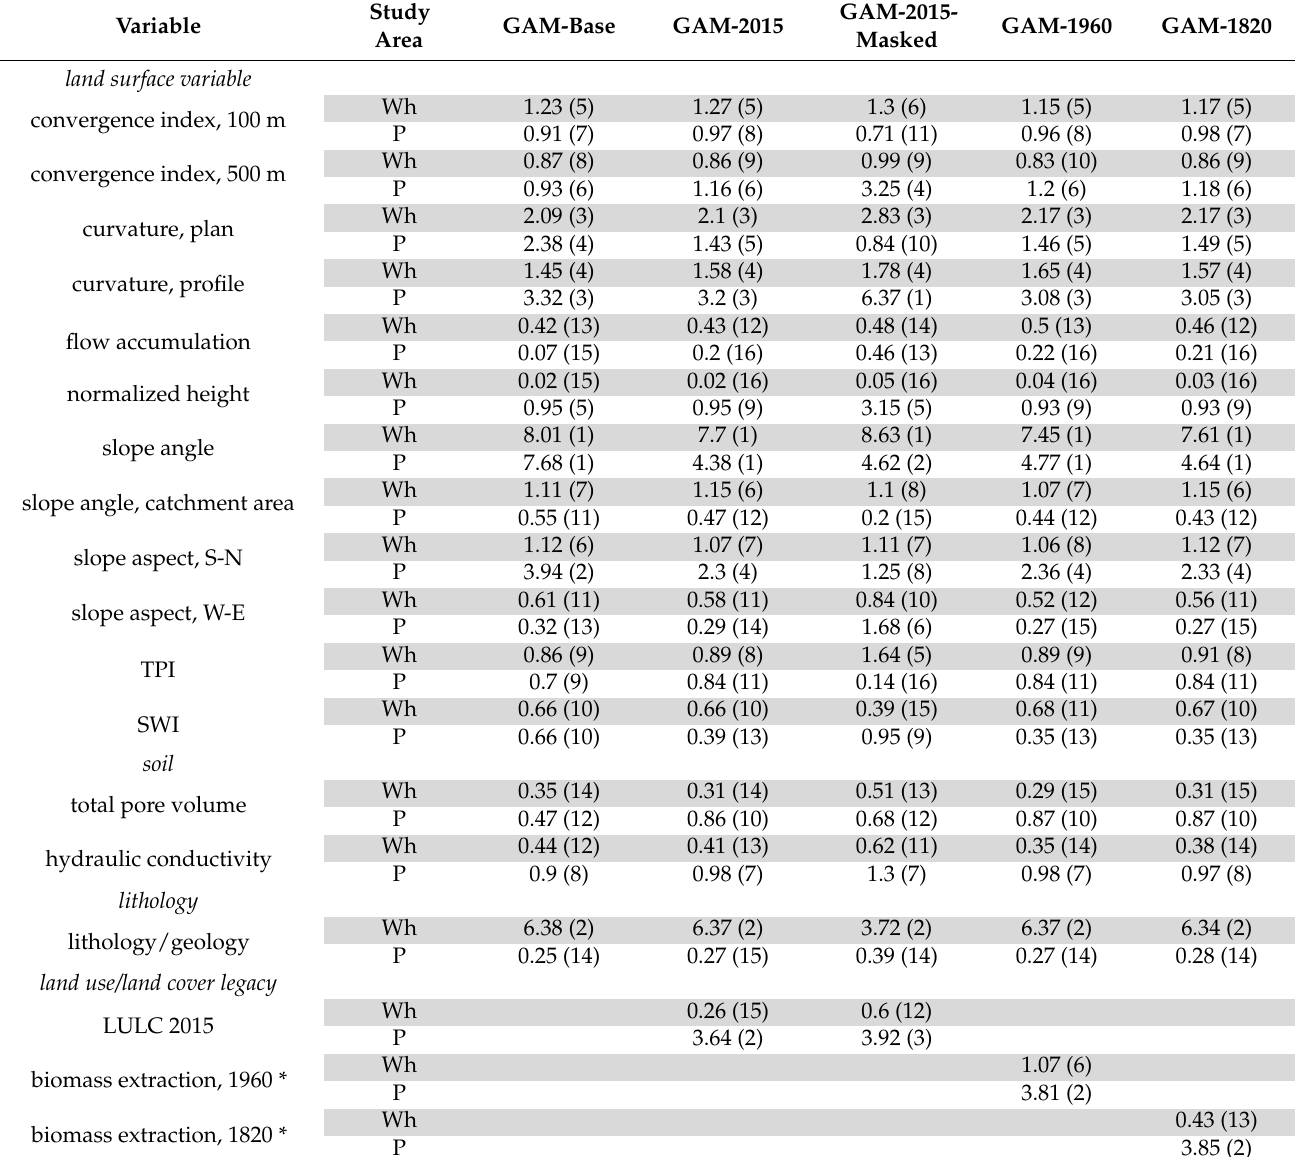
Table A6. Variable importance measured as mean decrease in deviance explained (%), rank of variable in